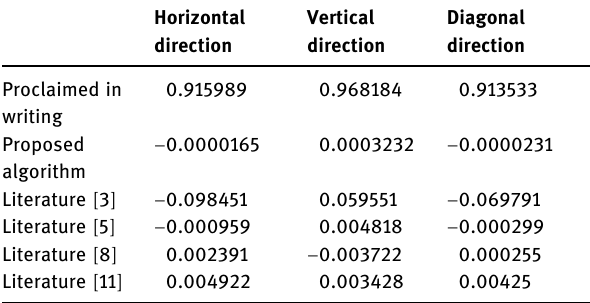
Table 4: Correlation results between the algorithm in this